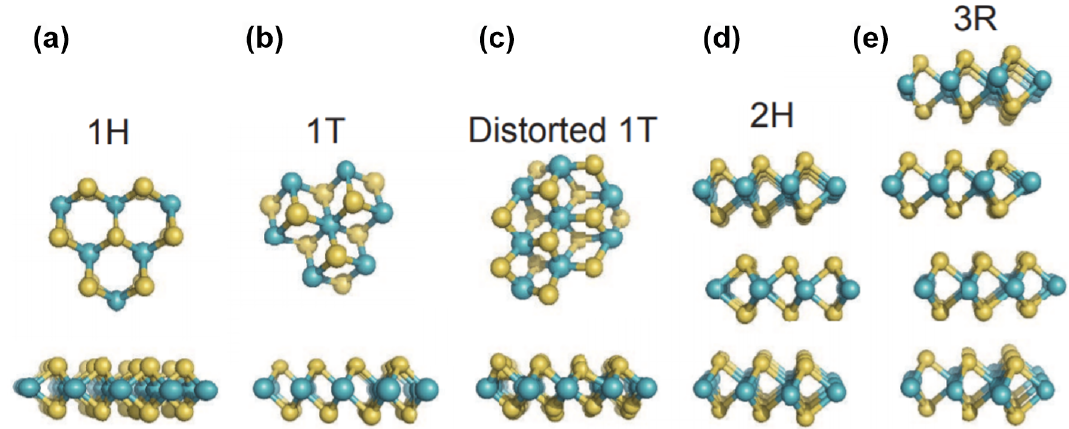
Figure 7. Crystal structures of predicted ground states for transition metal dichalcogenides (TMDs) with different polymorphisms. Reproduced with permission from ref [86]. Copyright 2016, American Chemical Society.